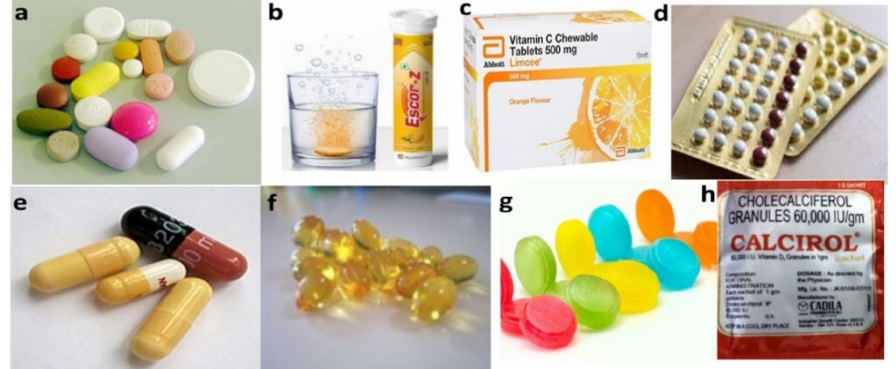
Figure 6. Solid unit dosage forms: ( a ) Tablets, ( b ) Effervescent tablets, ( c ) Chewable tablets, ( d ) Pills, ( e ) Hard-gelatine capsules, ( f ) Soft-gelatine capsules, ( g ) Lozenges. ( h ). Granules.